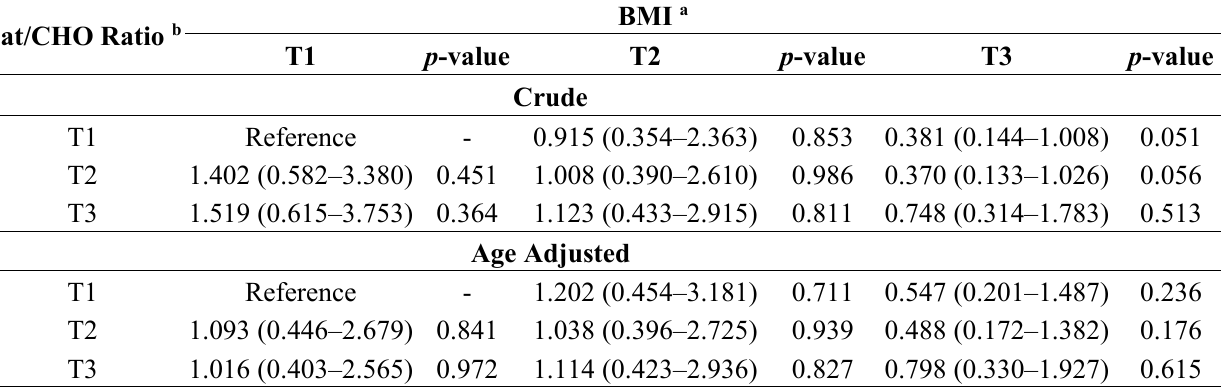
Table 3. Interactive effects of dietary fat/carbohydrate ratio and body mass index on iron deficiency anemia ( n =